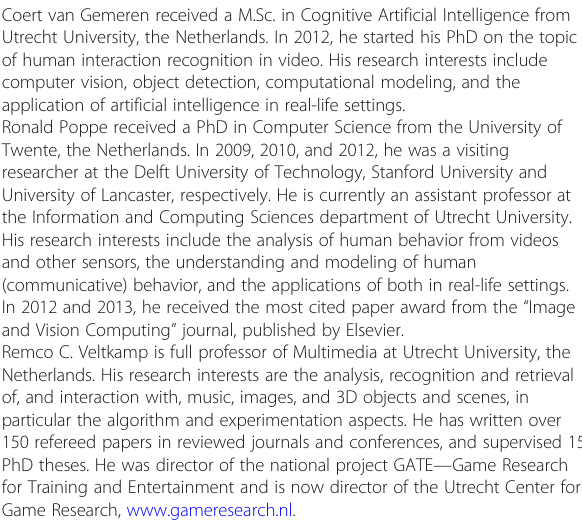
Table 6 d-mAP scores for the HOGHOF models on SBU Kinect. In columns the true class, in rows the tested class. Addition interactions from SBU Kinect include kick (KI), leave (LV),